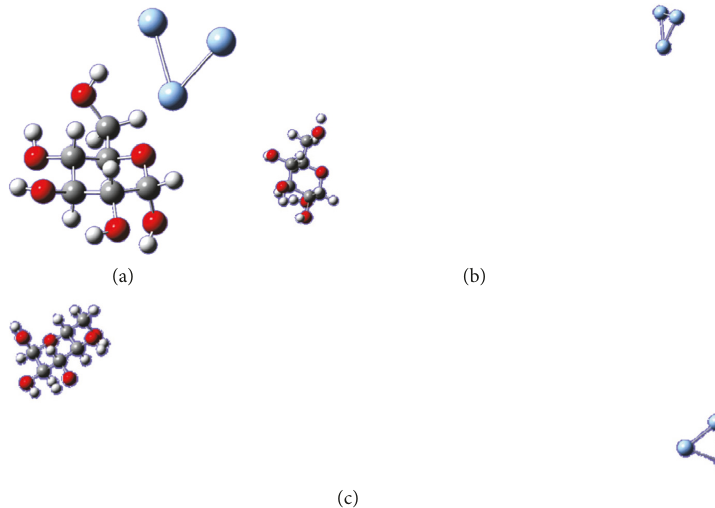
Figure 12: Molecular dynamics performed at 298.15 K. Glucose with 3-atom silver cluster at (a) 0 ps, (b) 5ps, and (c) 20ps.